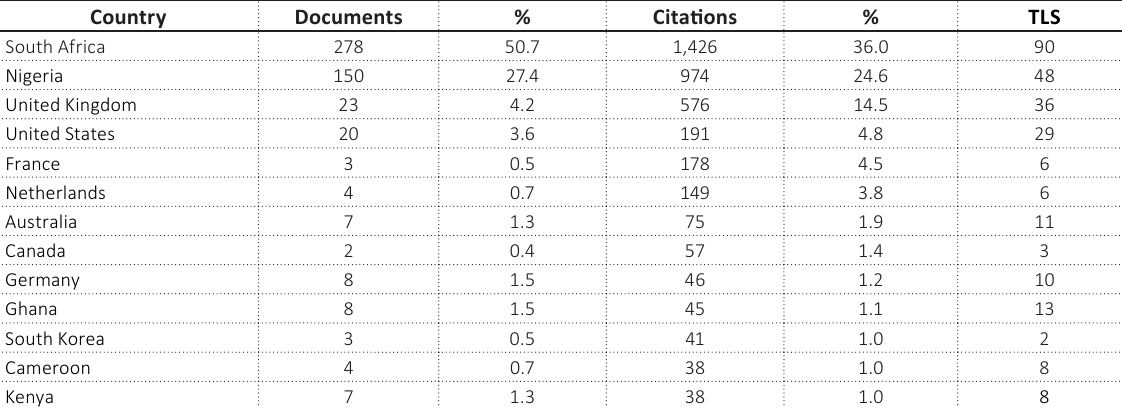
Table 2. Co-authorship outputs and citation analysis by countries